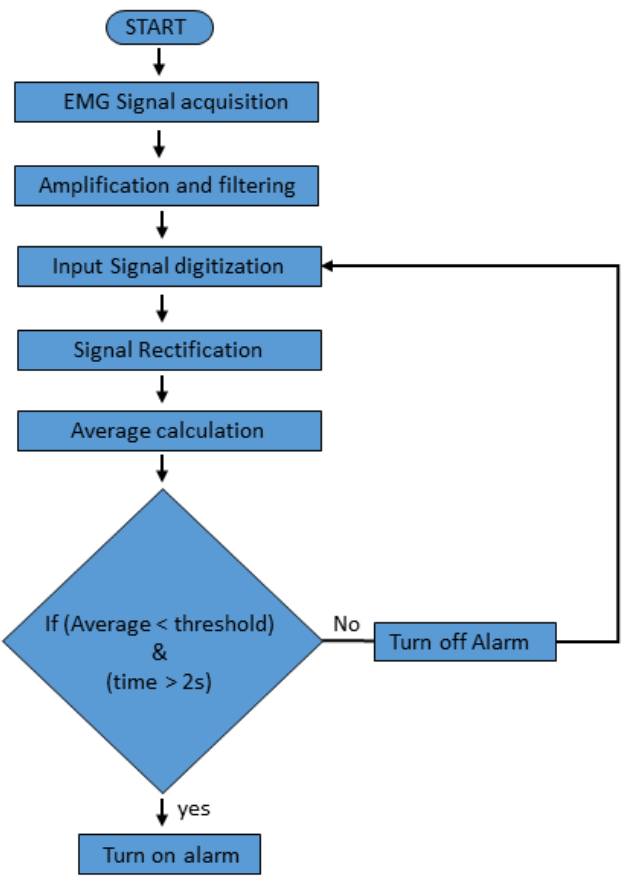
Figure 4. Flowchart of the proposed algorithm for driver drowsiness detection.